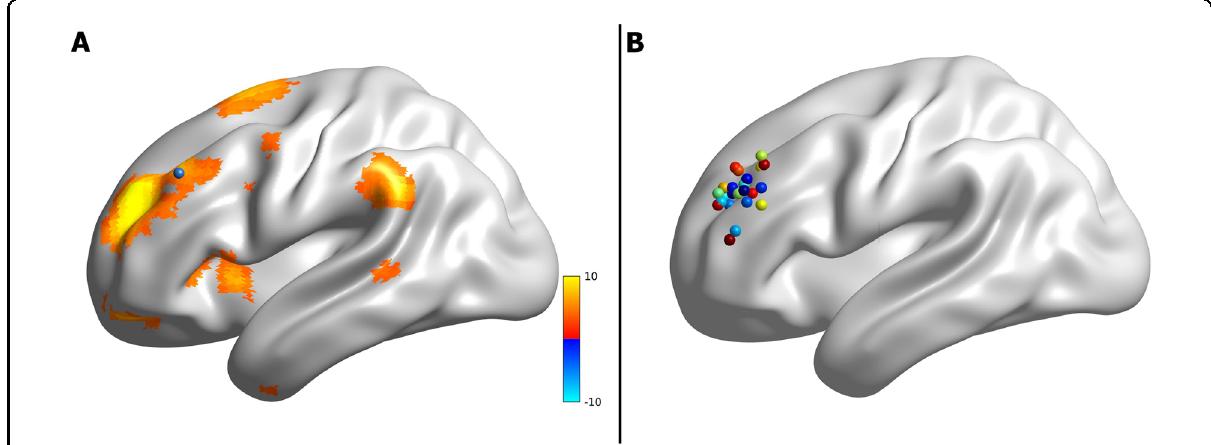
Fig. 2 Personalized left DLPFC sites. a An example of IC-DLPFC (warm colors) for a single subject from which the parameter estimates of personalized stimulation site (blue sphere) were extracted. b Personalized left DLPFC stimulation sites of all subjects from which parameter estimates were